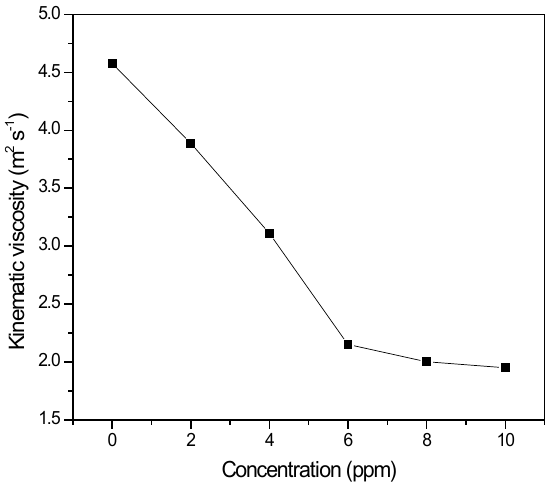
Figure 9: Study of variation of kinematic viscosity with concentration of additive.